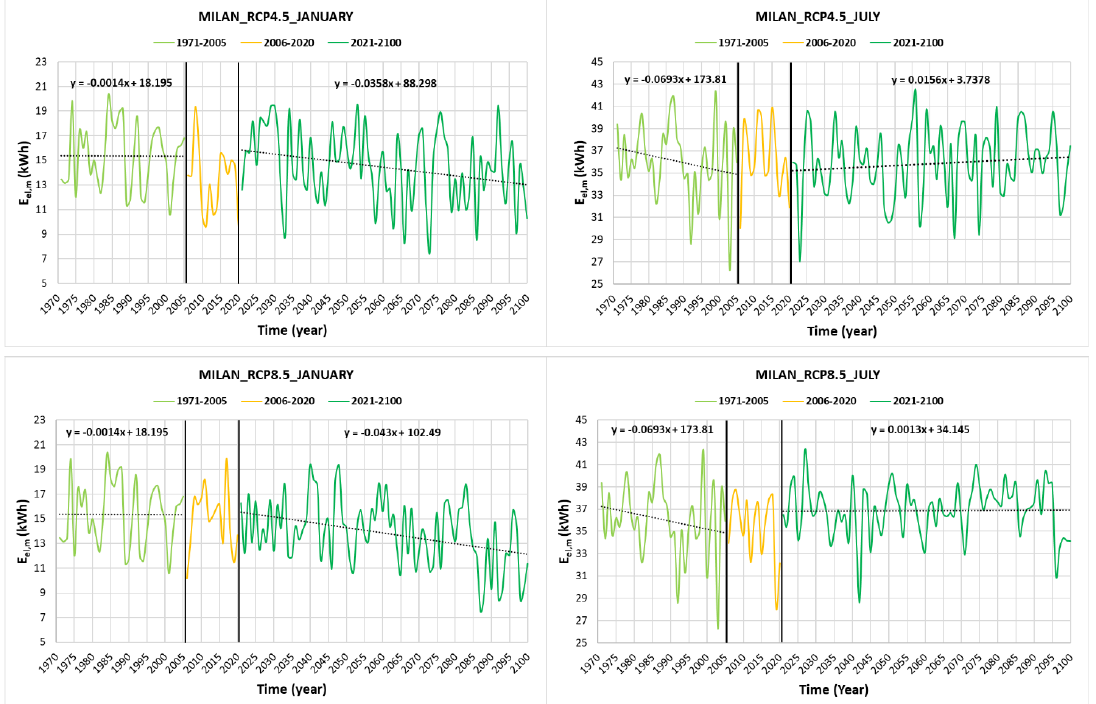
Figure 9. Milan’s monthly PV electricity variation in January ( left ) and July ( right ) from 1971 to 2100. ( Top ): RCP4.5, ( bottom ):